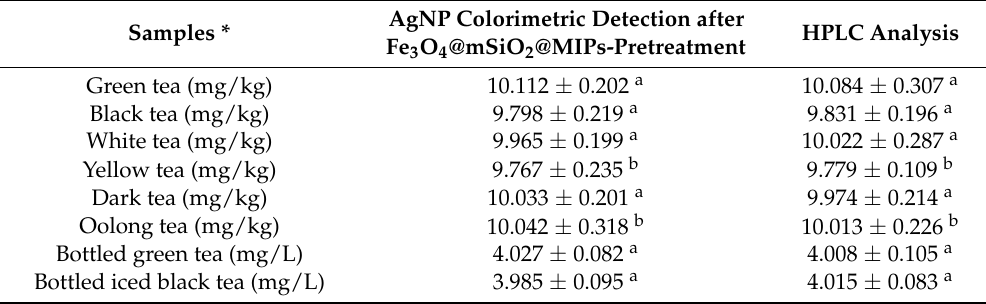
* Each one gram of green tea, black tea, white tea, yellow tea, dark tea, oolong tea was spiked with 10 µ L of cartap (1 mg/mL) before extracted with water, respectively; bottled green tea and bottled iced black tea were